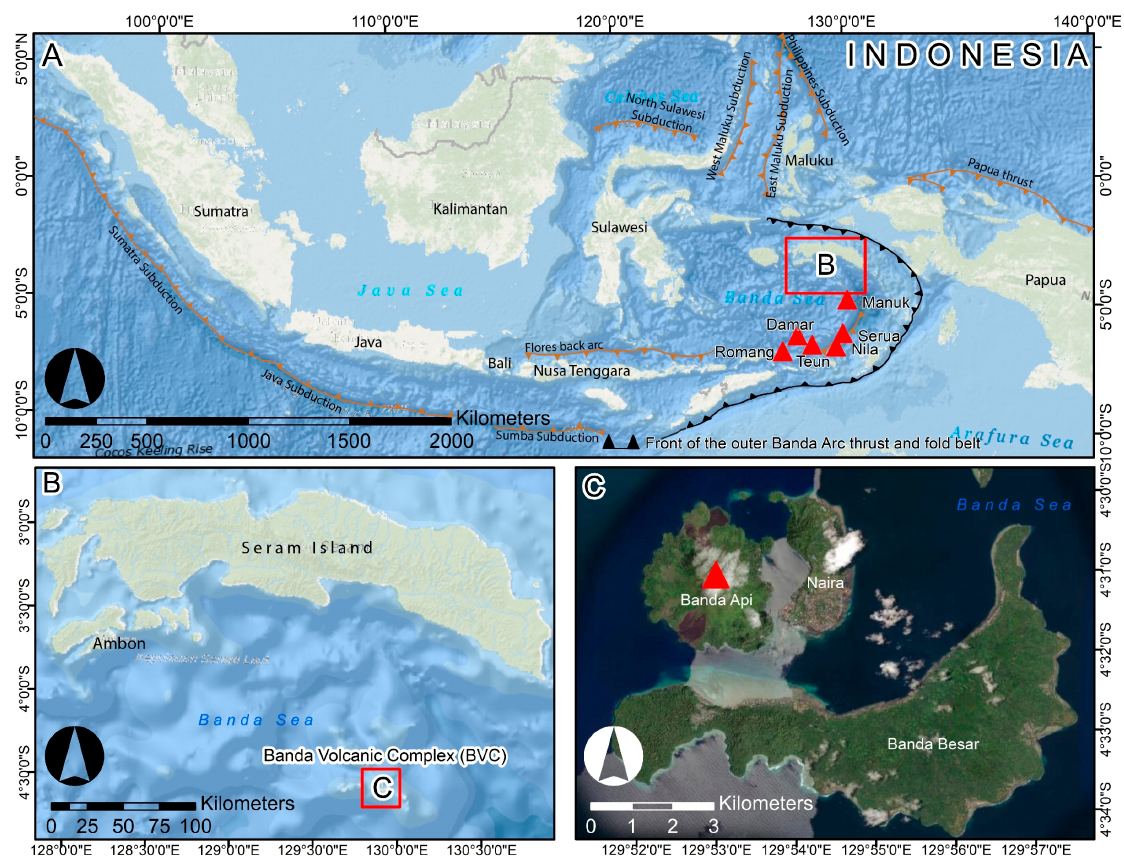
Figure 1. The complex subduction process in the Banda Sea ( A ) has a role in the formation of the islands of Banda Besar, Naira, and the Banda Api volcano in the Banda volcanic complex (BVC) ( B ), which is situated in the marine conservation zone of the Banda Sea, Maluku, Indonesia. The present eruptive activity is located at Banda Api, as shown by a red triangle symbol ( C ).